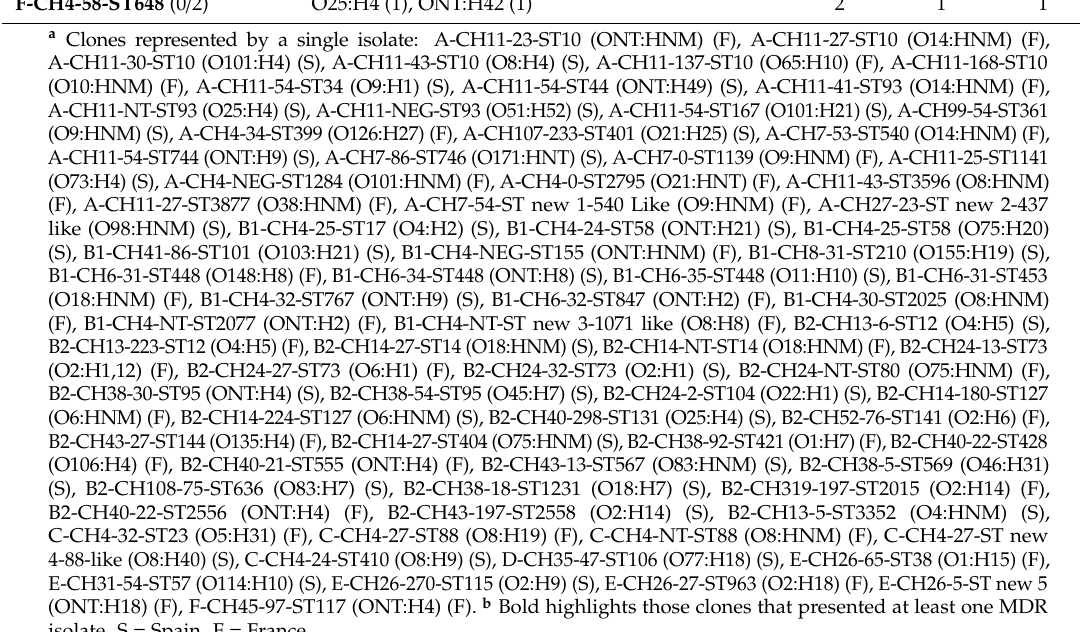
ExPEC UPEC MDR Status Status